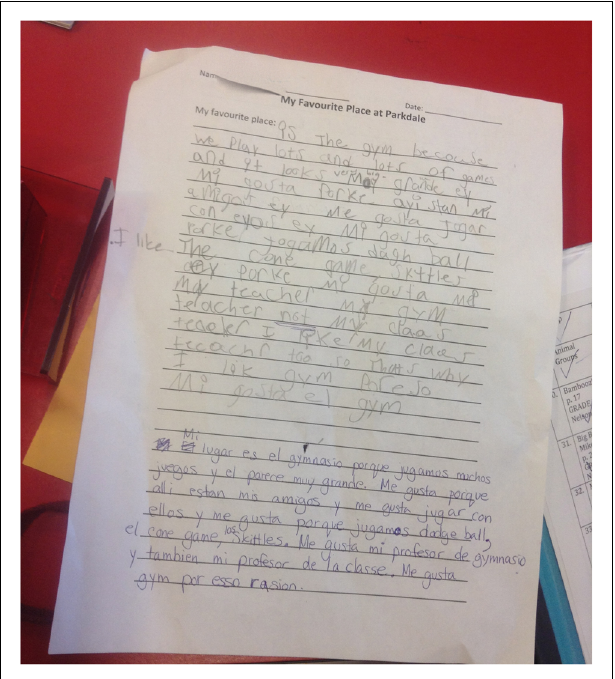
FIGURE 1 | Jose’s